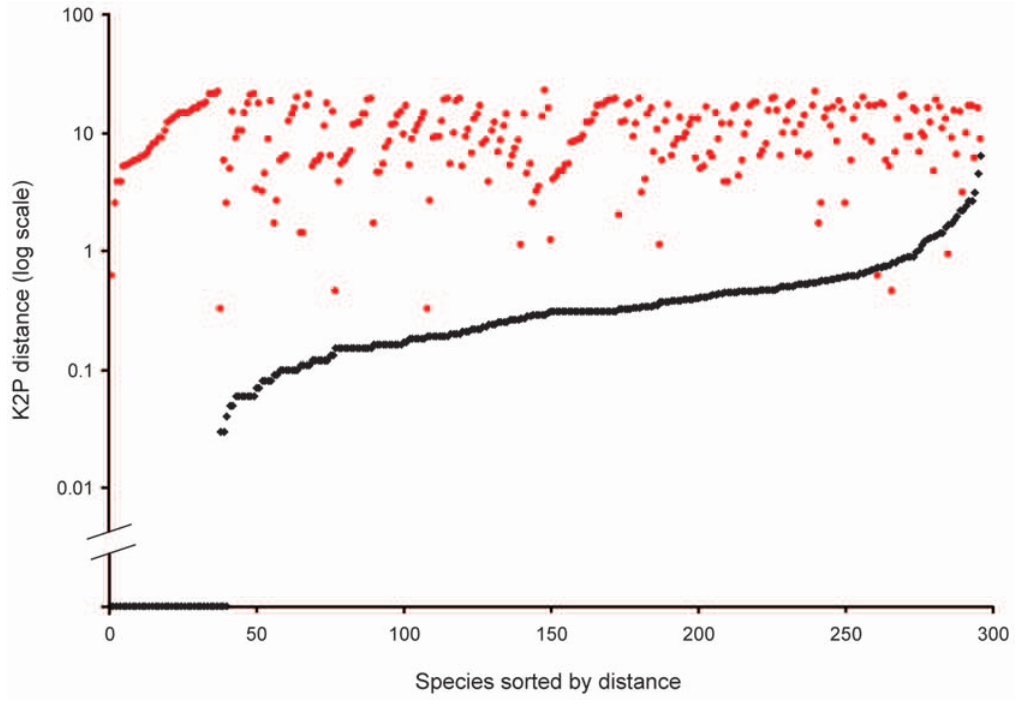
Figure 1. Half-logarithmic dot plot of genetic distances within each species against genetic distances to nearest-neighbor. For each species, there is a black dot showing intraspecific K2P distance and a red dot directly above or below it which shows the distance to its nearest neighbor. Sorting by intra- and interspecific distance allows the relative distances for each species to be seen. This graph indicates that few species have nearest-neighbor distances that are less than the mean intraspecific distance for that species. A line drawn at 1% separates most intraspecific from interspecific values.